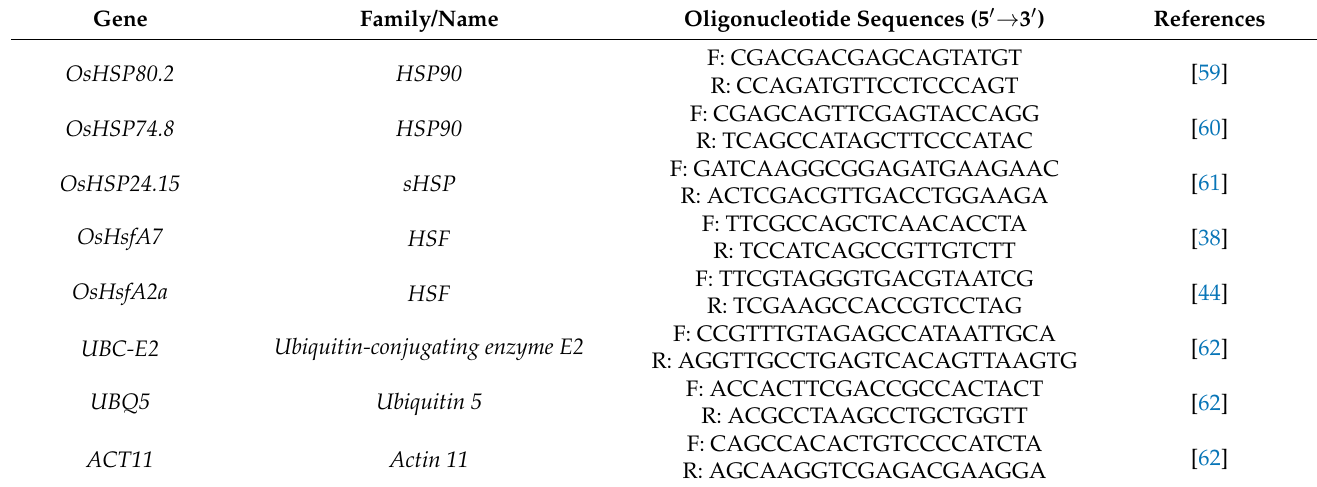
Table 2. Oligonucleotides used for the qRT-PCR